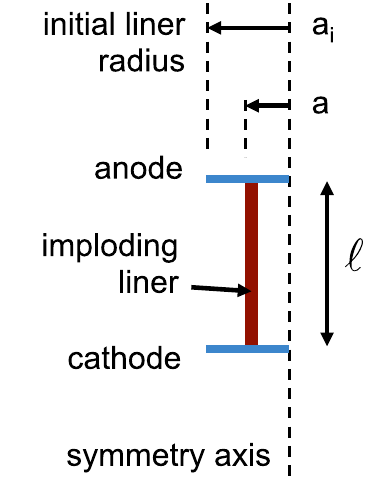
FIG. 8. Idealized representation of an imploding liner. The quantity a is the liner radius at time t , and ℓ is the length of the liner. For the MagLIF loads assumed in this article a i ¼ 0 . 5 cm and ℓ ¼ 1 . 0 cm